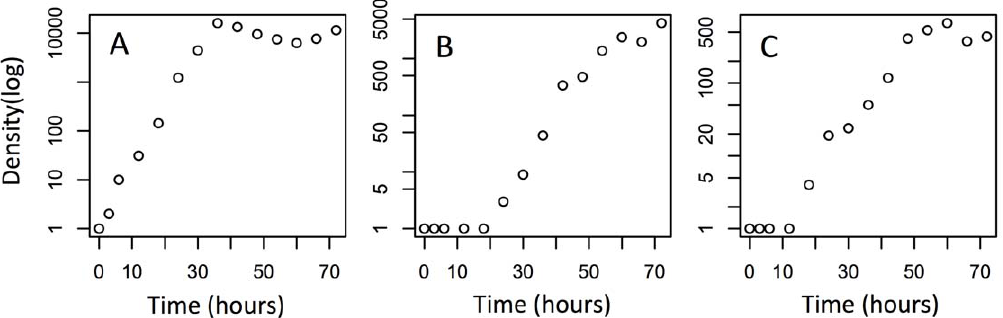
Figure 2. Single-species population growth curves of the three protozoan species used in the community-assembly experiment. A, B, and C as in Figure 1.